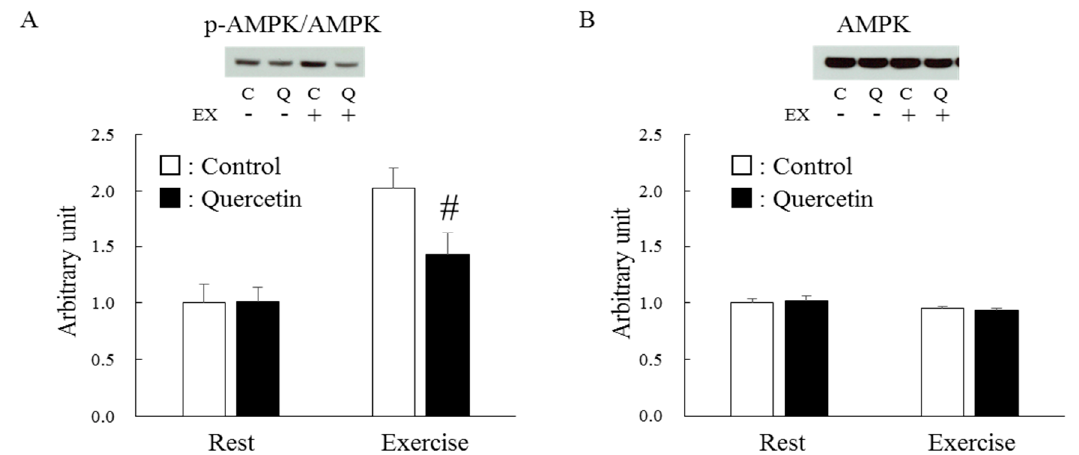
Figure 8. Effects of 7-day quercetin treatment on exercise-induced AMPK phosphorylation. Rats were assigned to either a control or quercetin groups and were maintained under ad libitum feeding for 7 days. After that, rats underwent swimming exercise for 1 h. Immediately after exercise, epitrochlearis muscles were dissected out as Western blot samples for p-AMPK ( A ) and AMPK ( B ). A representative blot is shown above each figures. The obtained values of p-AMPK were normalized with the value for AMPK. Values are means ± SE ( n = 6–7). # p < 0.05 vs. control in exercised group. C: control, Q: